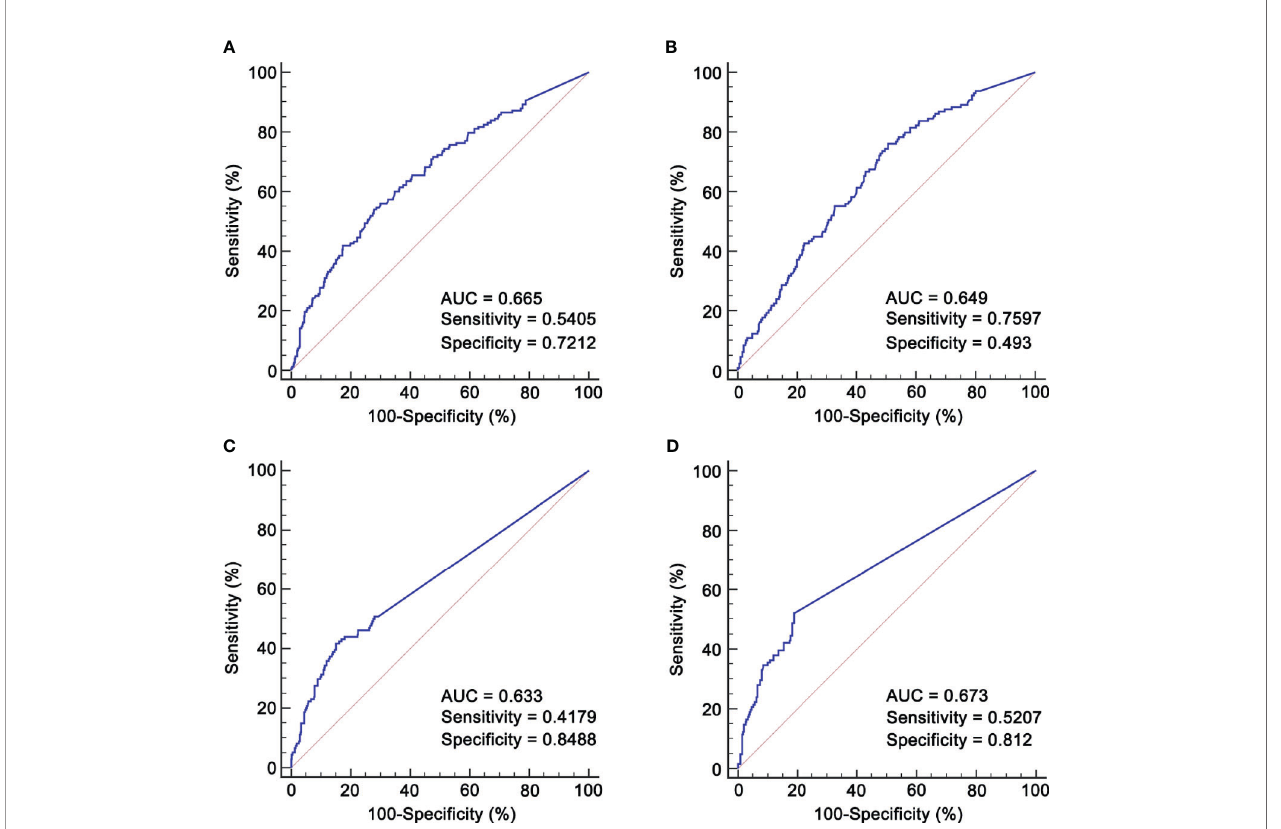
FIGURE 2 | ROCs for identifying cut-off values of pre-IC DNA and RR. (A) Pre-IC DNA in patients receiving 2 cycles of IC; (B) Pre-IC DNA in patients receiving 3 cycles of IC; (C) RR in patients receiving 2 cycles of IC; (D) RR in patients receiving 3 cycles of IC. ROC, receiver operating curve; pre-IC DNA, pre-treatment Epstein-Barr virus DNA; RR, decrease rate; IC, induction chemotherapy; AUC, area under curve.